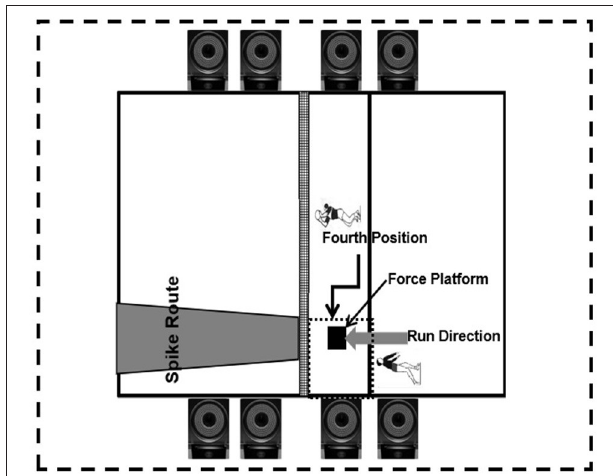
FIGURE 1 | Illustration of experiment.